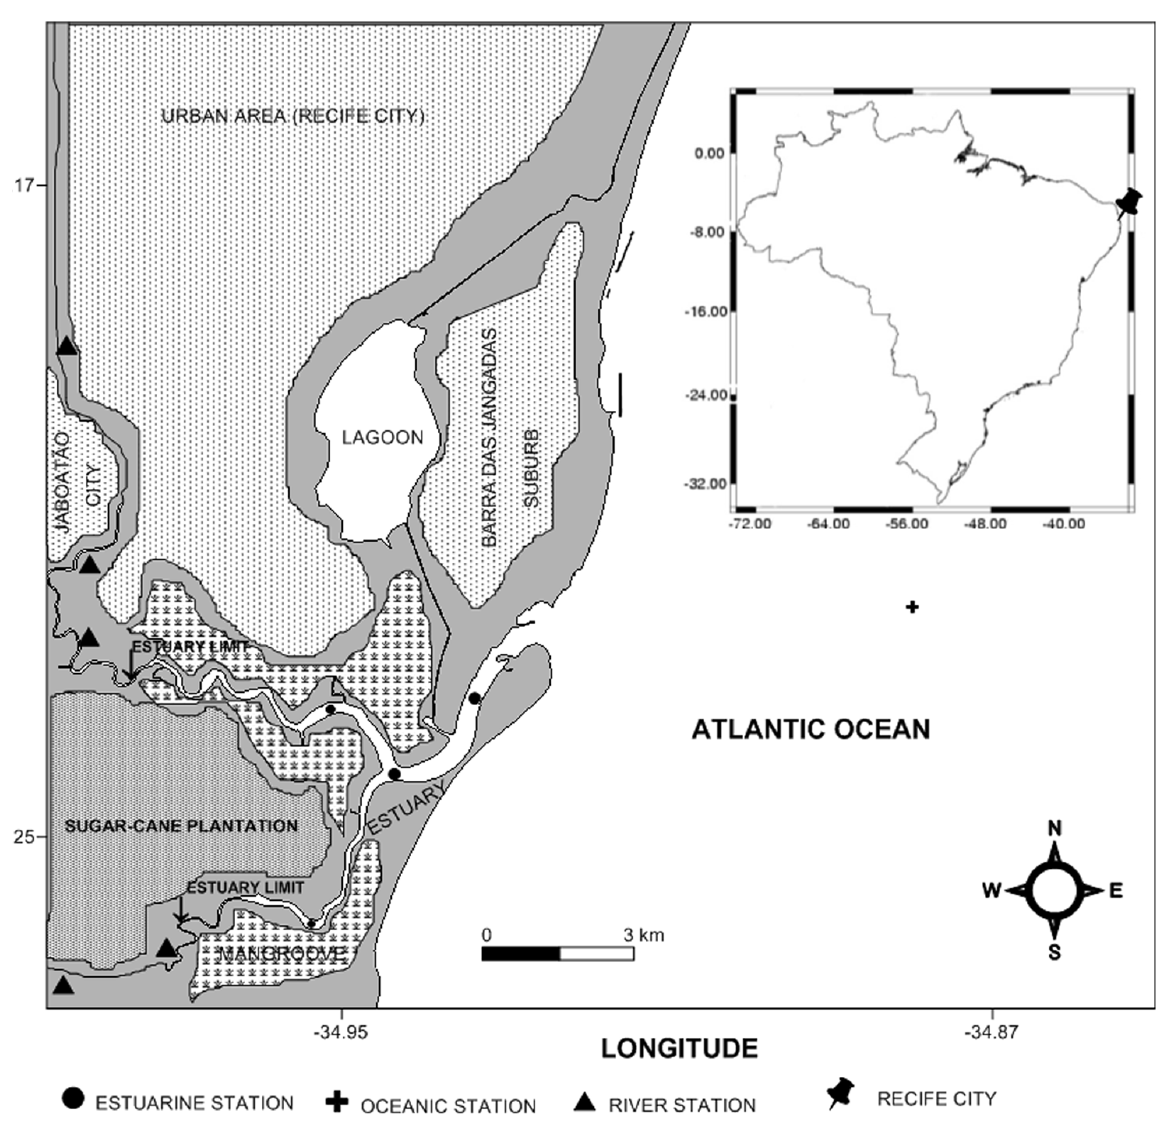
Fig. 1 – Map of the Barra das Jangadas Estuary (BJE), NE